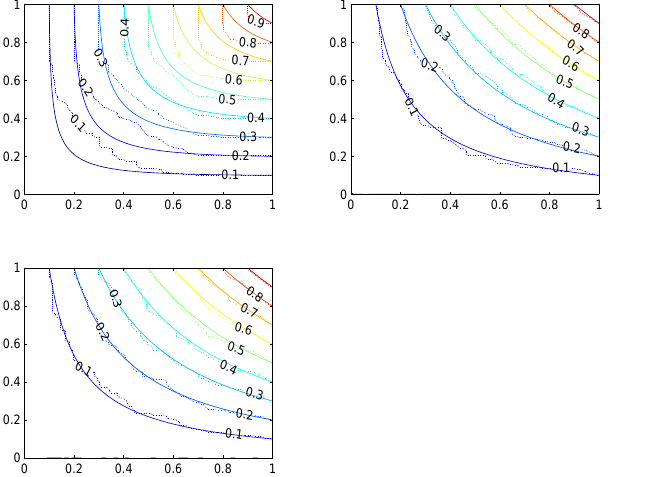
are simulated using the 3- and 4-dimensional vine copulas, respectively, based on the method described in Sect. 2.3. Ta- ble 2 shows the good correspondence between the observed and simulated pairwise dependences. To be able to transform samples from the fitted copula to real samples, the (inverse) marginal cumulative distribution functions of p d , W , V and D are